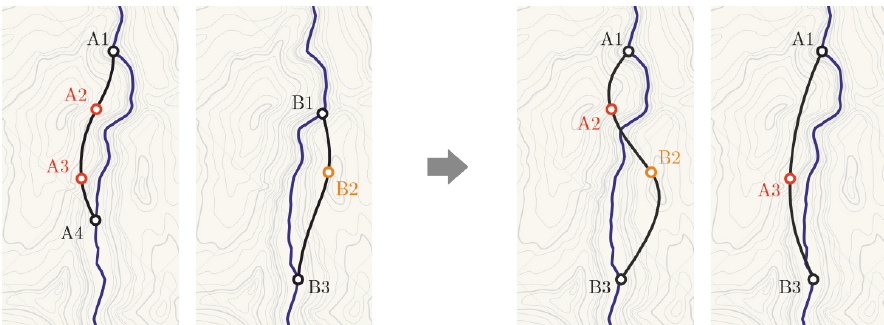
Figure 10. Example of the exchange of nodes between two individuals during a crossover operation. Note how the highest and lowest nodes (A1 and B3) are directly inherited by the offspring, while the internal nodes (A2, A3, and B2) are randomly distributed among them. End nodes A4 and B1 are thus not